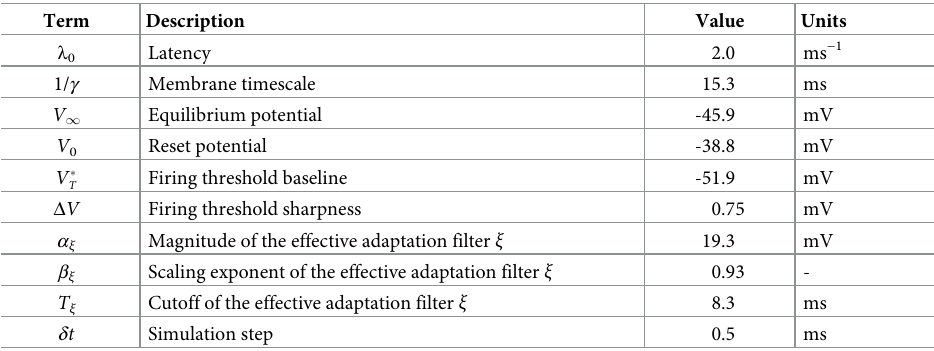
Table 1. Simulation parameters of the GLIF- ξ